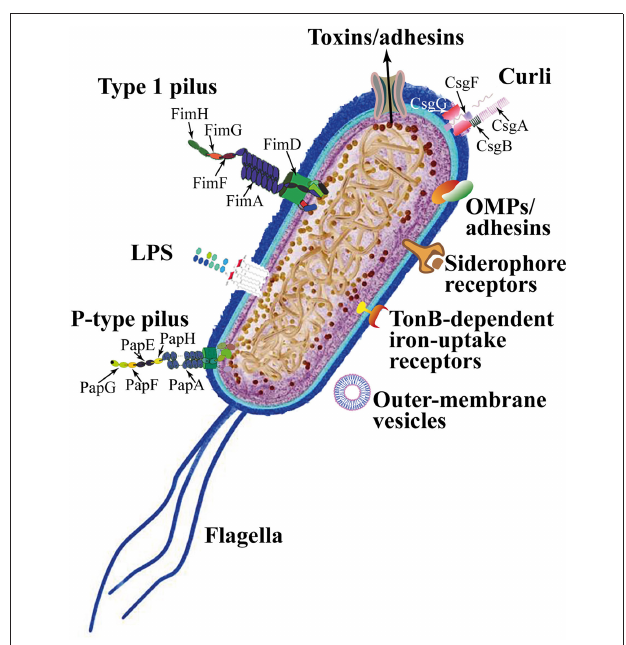
FIGURE 2 | Escherichia coli adhesins and harboring/motile